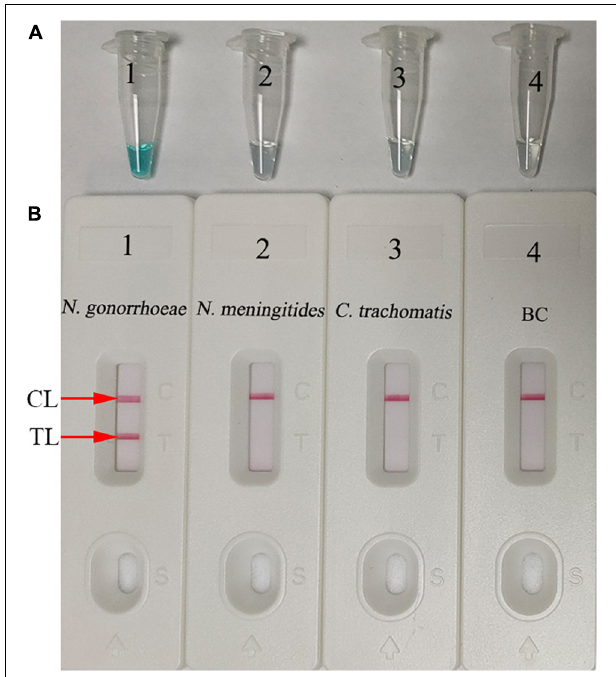
FIGURE 3 | Determination and confirmation of N. gonorrhoeae- MCDA products. N. gonorrhoeae -MCDA products were monitored using a colorimetric indicator (A) and a gold nanoparticle-based biosensor (B) . Tube 1/Biosensor 1: positive result for the N. gonorrhoeae reference strain (ATCC 49926); Tube 2/Biosensor 2: negative result for Neisseria meningitides ; Tube 3/Biosensor 3: negative result for Chlamydia trachomatis ; Tube 4/Biosensor 4: blank control (distilled water). TL, test line; CL, control